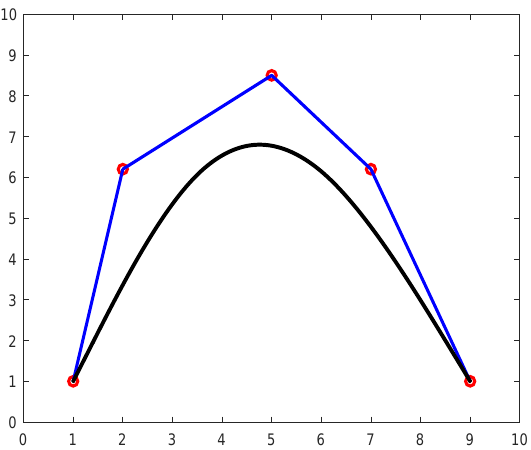
Figure 13. Convex hull property of a rational curve.